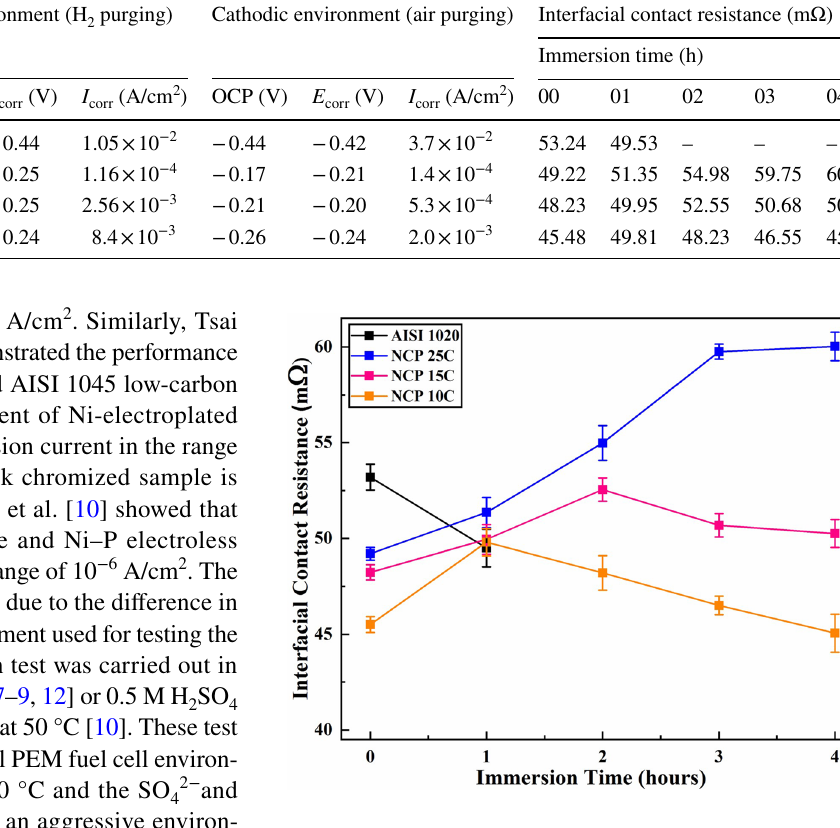
Fig. 8 Variation of interfacial contact resistance (ICR) of Ni–Cr–P coating samples and AISI 1020 bare substrate with an immersion time of samples in 0.5 M H 2 SO 4 and 2 ppm HF at 80